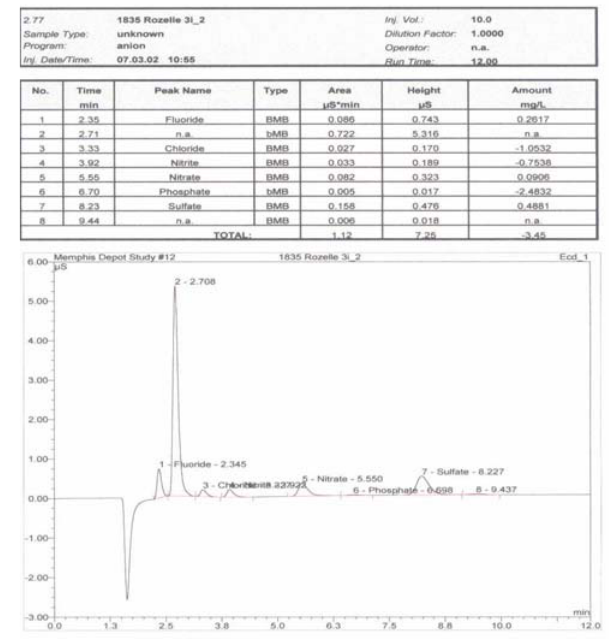
Figure 6: IC Results for Cane Creek